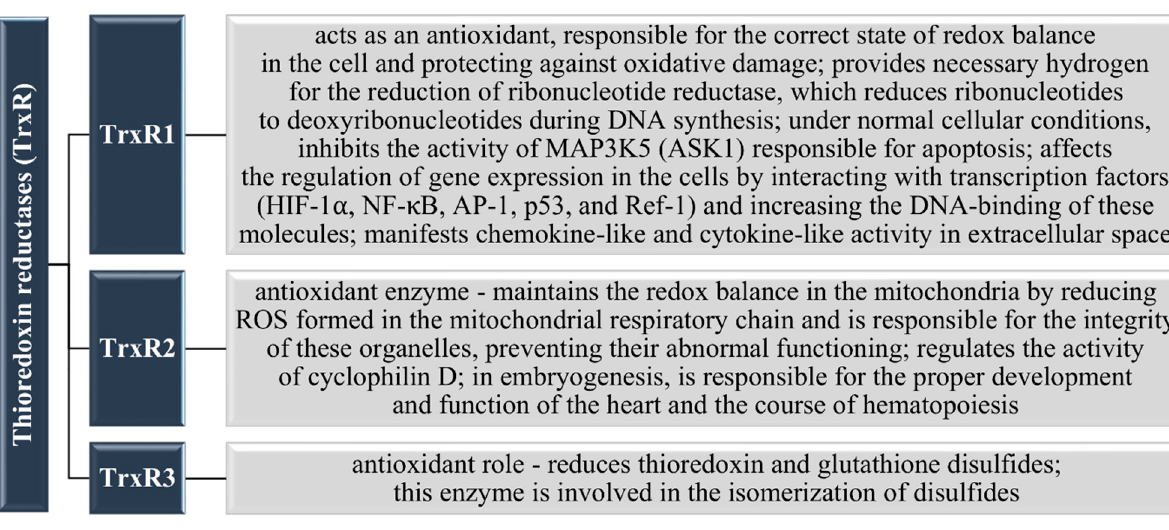
Figure 4. Selenoproteins of the thioredoxin reductases (TrxR) family and their functions [102–105].